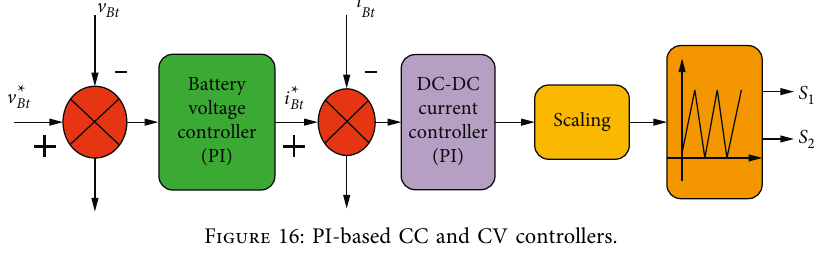
Figure 16: PI-based CC and CV controllers.